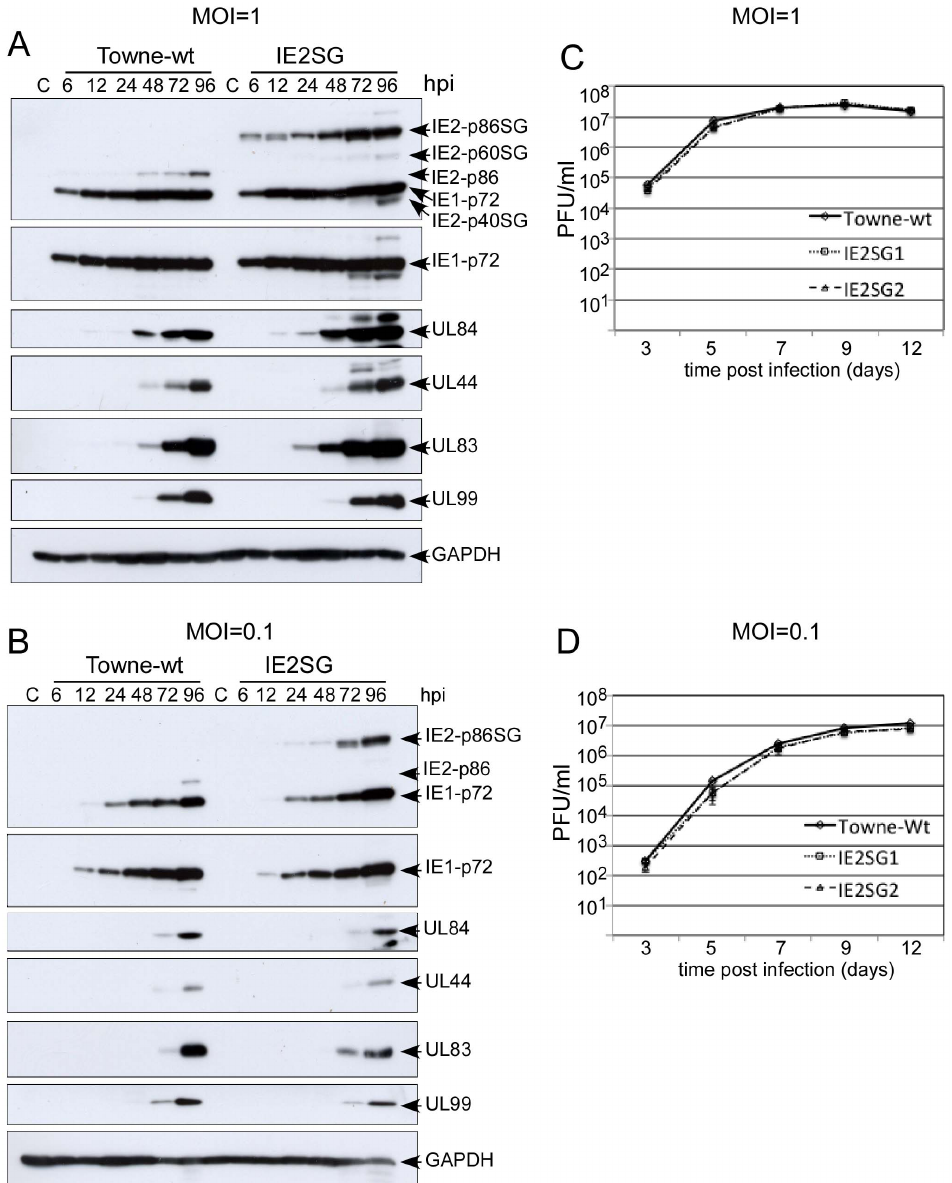
Figure 2. Growth property of HCMV recombinant virus IE2-p86SG. Expression of viral proteins in HFF cells infected with either wt Towne or IE2SG (A and B). HFF cells were infected at high (1 PFU/cell) or low (0.1 PFU/cell) MOI and analyzed by Western blot analysis. MIE viral proteins IE1- p72, IE2-p86, IE2-p86SG, early viral proteins UL84 and UL44, early/late viral proteins UL83 and late viral protein UL99, and cellular protein GAPDH were detected using specific antibodies as described in the Materials and Methods. (C and D) Growth curves of wt HCMV BAC Towne and Towne-IE2SG after high (1 PFU/cell) or low (0.1 PFU/cell) MOI. Cell culture supernatants were harvested at various d p.i. for viral titers via a GFP-based plaque assay. The standard deviations indicated for each data point on the graphs were derived from three independent